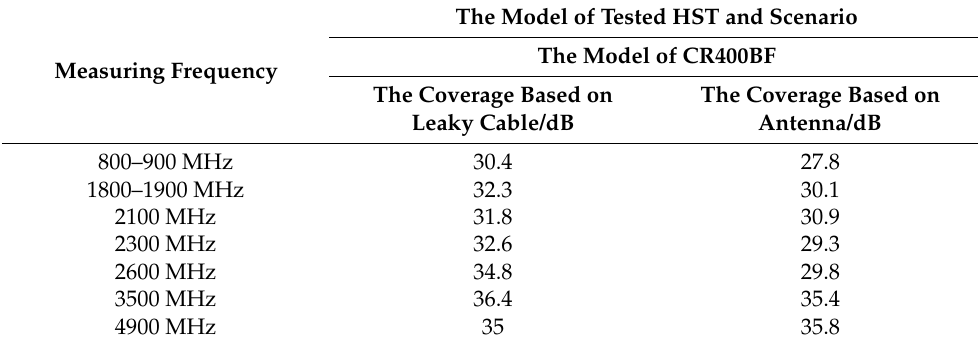
Table 1. Penetration losses in different frequency bands [12].